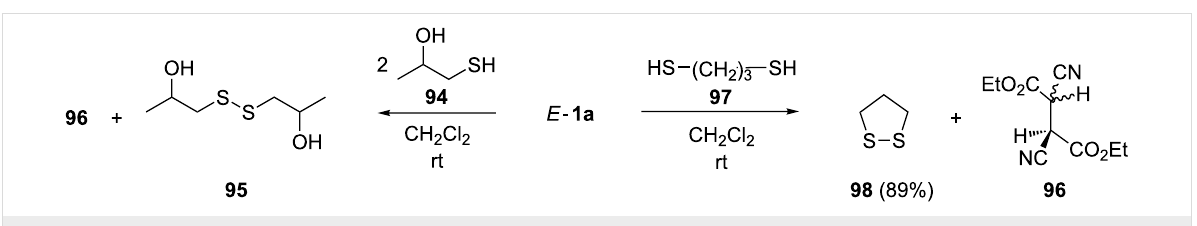
Scheme 30: Formation of disulfides through reaction of thiols with E - 1a